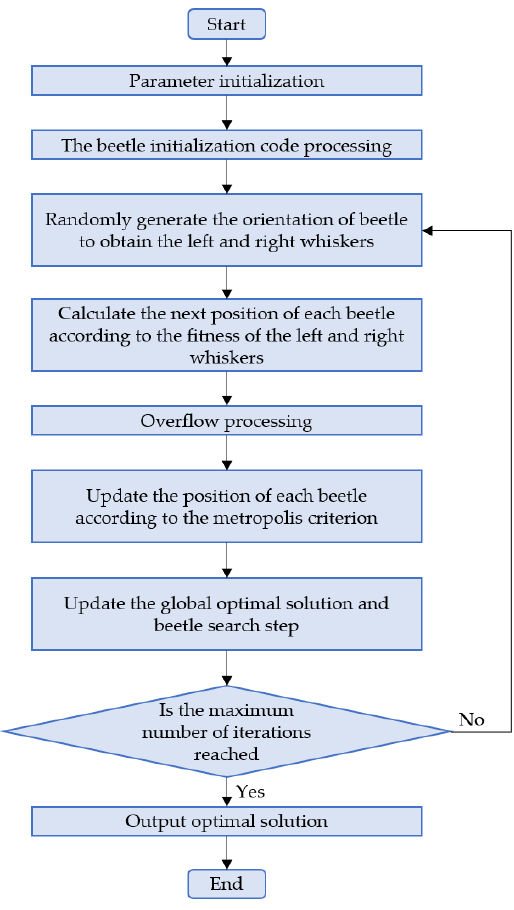
Figure 3. The flow chart of BAS.